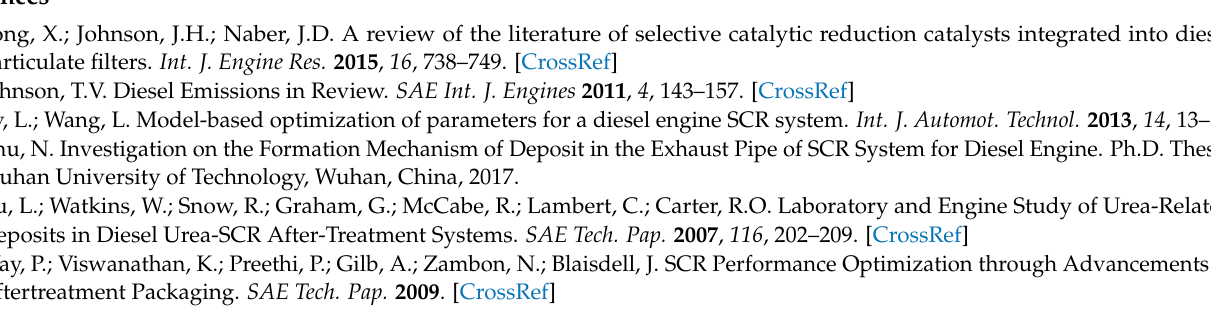
K of CYA pyrolysis